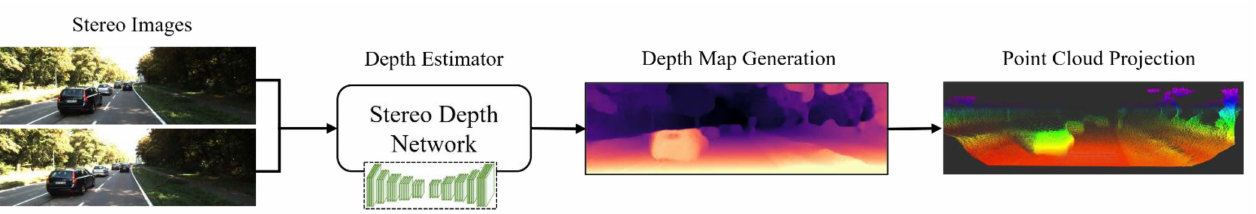
Figure 2. The proposed pipeline to generate pseudo-point-cloud-like LiDAR. From the stereo images, depth map prediction is completed using a modified stereo depth network, then back-projecting the pixel to 3D point coordinate system cloud generation from the depth map. ( Left image ): input to pipeline-rectified stereo images from KITTI [4]; ( middle image ): estimated depth map using U-Net-based depth network; ( right image ): pseudo point cloud generation from the